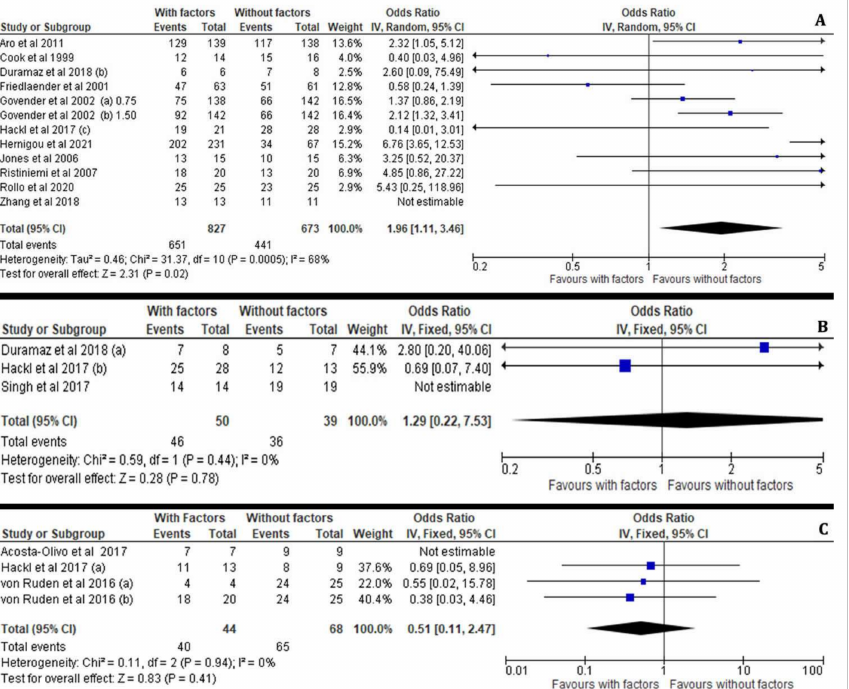
Figure 11. Forest plots presenting the effectiveness of osteoinductive factors in the bone heal- ing process according to fracture anatomical location such as tibia ( A ), femur ( B ) and upper limb ( C )